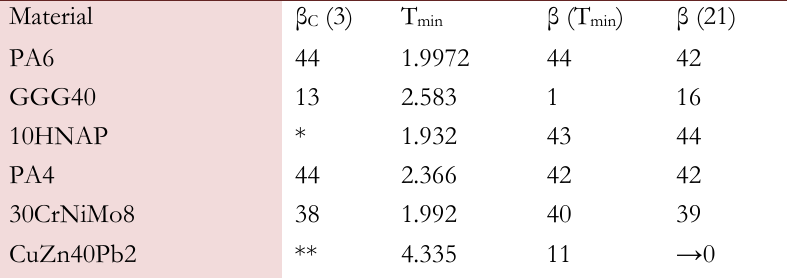
Table 2: The values of rotation angles β and minimum scatters of fatigue life (*out of range > 3 ; ** out of range